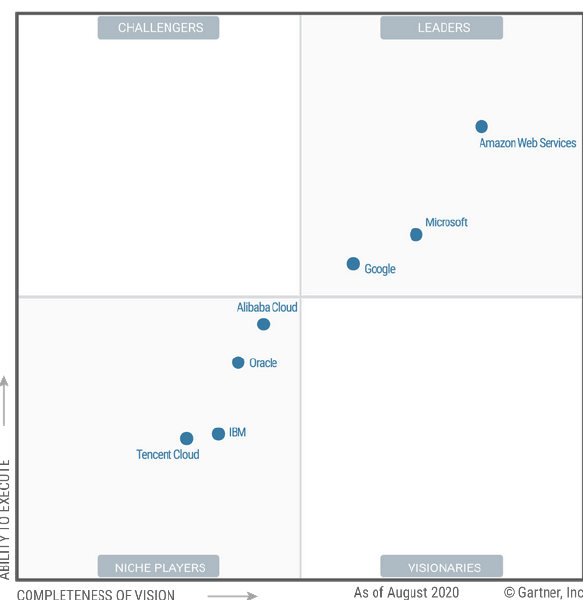
Figure 1. Gartner’s Magic Quadrant for CIPS vendors (Source: Bala et al.